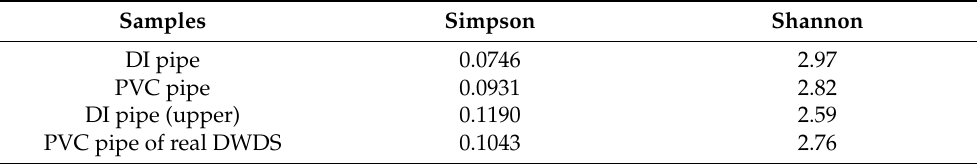
Table 1. Microbial diversity (Simpson/Shannon) index in different pipe